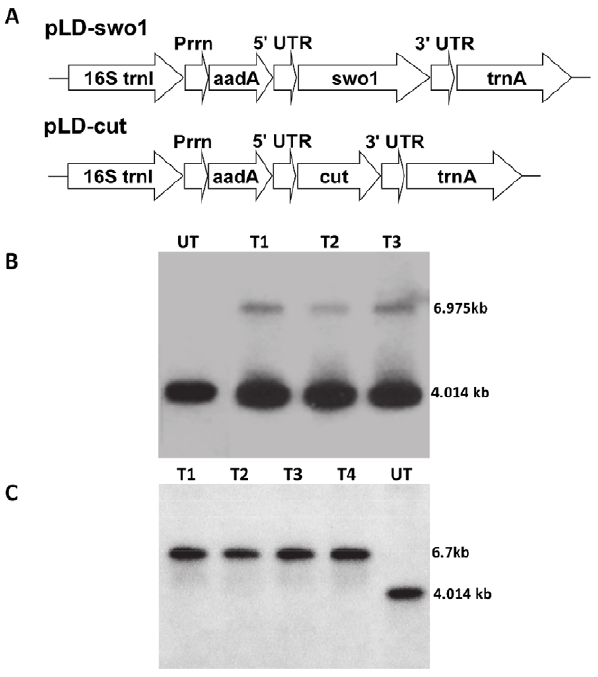
Figure 1. Evaluation of transgene integration and homoplasmy by Southern blot analysis. A, Schematic representation of the chloroplast transformation vectors pLD-swo1 and pLD-cut. Prrn, rRNA operon promoter; aad A, aminoglycoside 3 9 -adenylyltransferase gene; 5 9 UTR, promoter and 5 9 untranslated region of psb A gene; 3 9 UTR, 3 9 untranslated region of psb A gene. B, Southern blot analysis of independent cutinase transplastomic lines hybridized with chloroplast flanking sequence probe showing heteroplasmy (UT, untransformed; T1–T3, transplastomic lines). C, Southern blot analysis of independent swollenin transplastomic lines hybridized with chloroplast flanking sequence probe showing homoplasmy (UT, untransformed; T1–T4, transplastomic